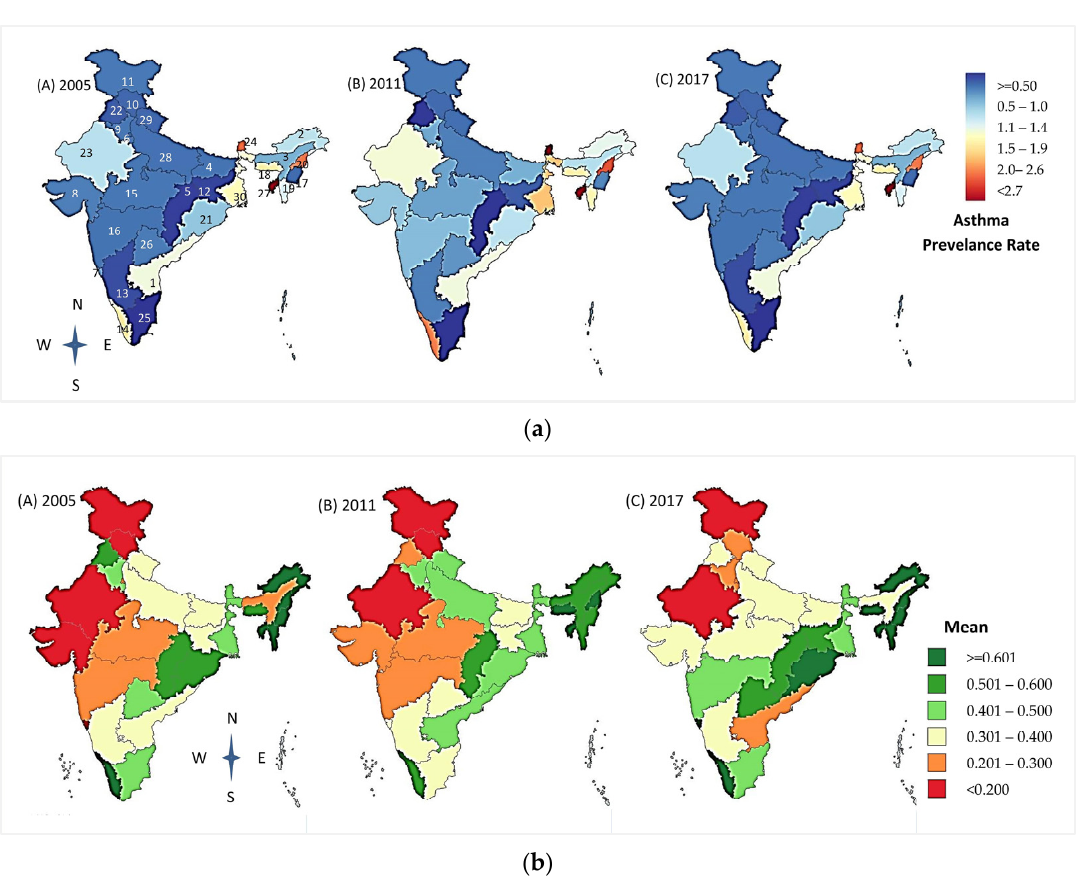
Figure 1. Distribution of ( a ) asthma prevalence rate, ( b ) NDVI across states and union territories in India in 2005, 2011, and 2017.